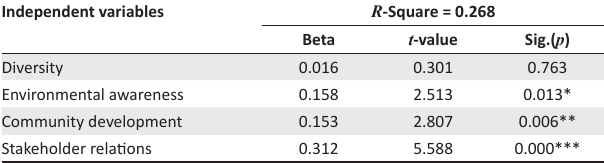
TABLE 7: Influence of the independent variables and intervening variable on the dependent variable. Independent and intervening variables